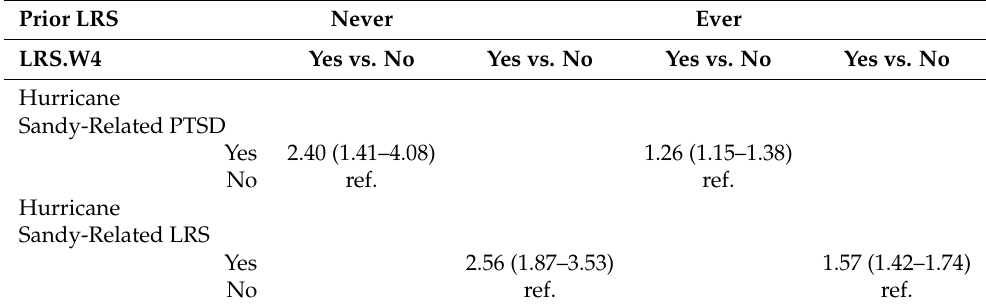
Table 3. Adjusted Risk Ratios (aRR) for the association between Lower Respiratory Symptoms (LRS) at wave 4 and Hurricane Sandy exposures, stratified by presence/absence of prior LRS, among the World Trade Center Health Registry enrollees